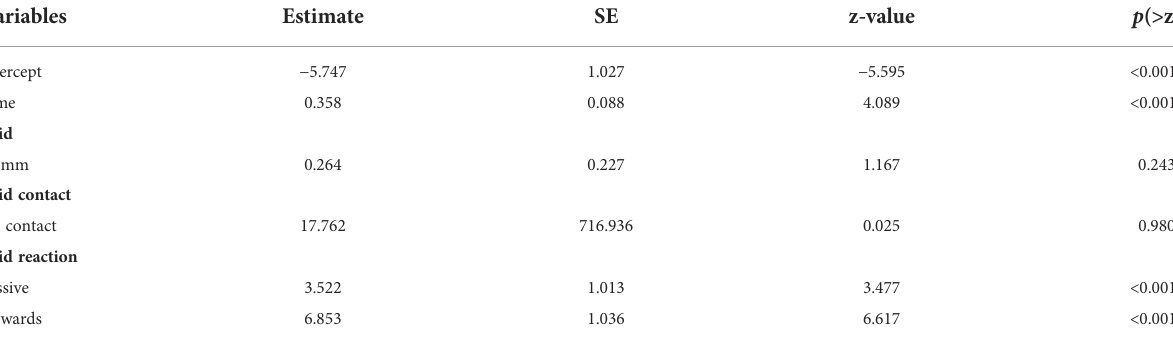
TABLE 4 Generalized linear model outcome including all variables in the lowest AICc model, estimates, standard error (SE), z-value, and p (>z).